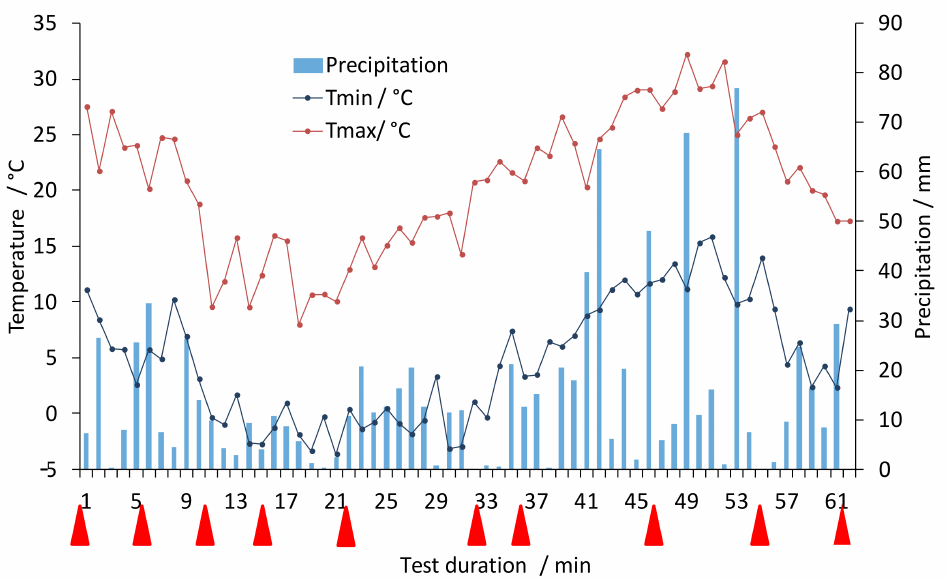
Figure 2. Weather data simulated for the site of the out-door prototype testing (Romanshorn, CH) during the period of outdoor degradation tests (data provided by meteoblue.com).